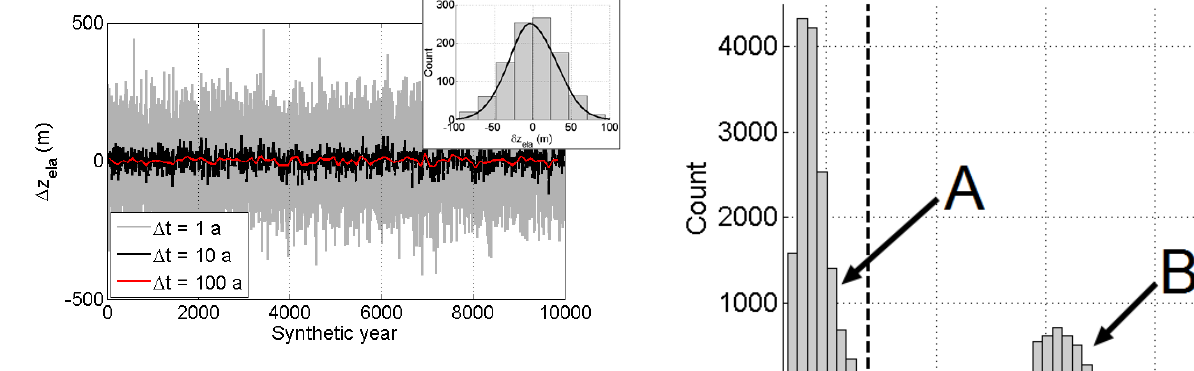
Fig. 7. Synthetic annual ( 1t =1a) variability in equilibrium line altitude ( 1z ela ) over 10000yr, generated using the 1T / 1t distri- bution shown in Fig. 6 and a lapse rate ( 1T / 1z) of 6.7Kkm − 1 . The corresponding decadal and centurial variability are also shown ( 1t =10 and 100a, respectively). Inset: Histogram and normal dis- tribution (mean=0m; standard deviation=30m) of decadal z ela perturbations ( δz ela ) .